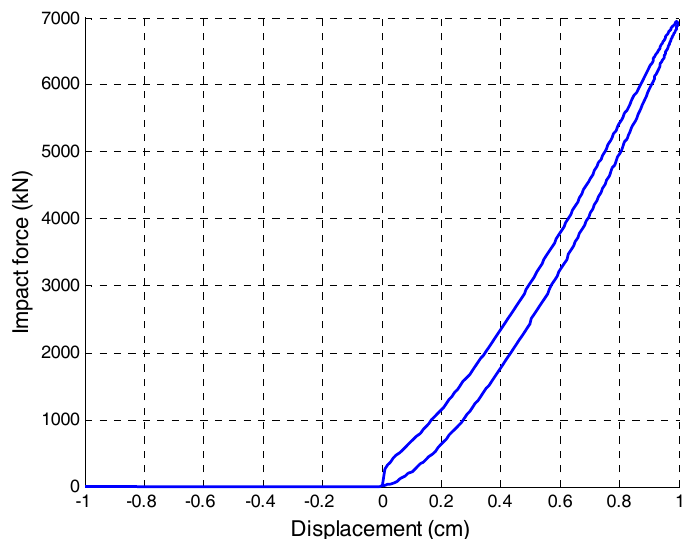
Figure 4. Relation between impact force and displacement during impact between two structural elements.